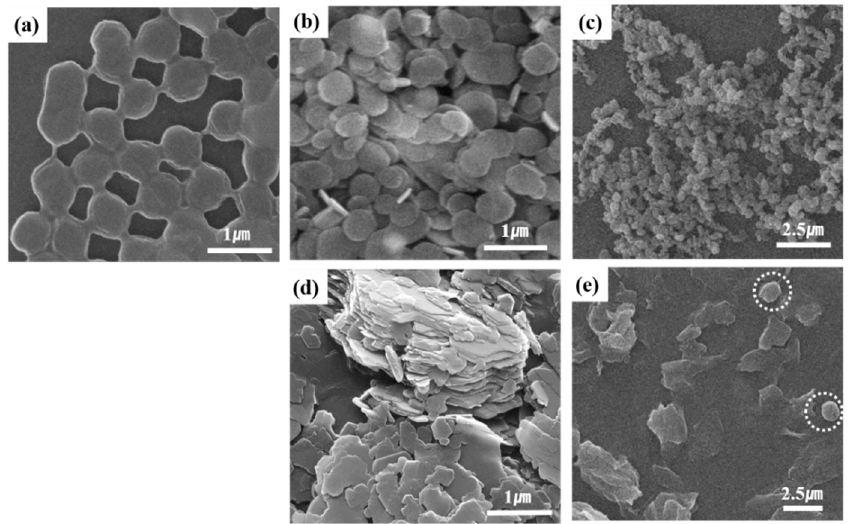
Figure 2. Scanning electron microscope images of FKC, clays, and FKC + clay mixtures. ( a ) FKC; ( b ) LDH; ( c ) FKC + LDH; ( d ) KA; and ( e ) FKC + KA.